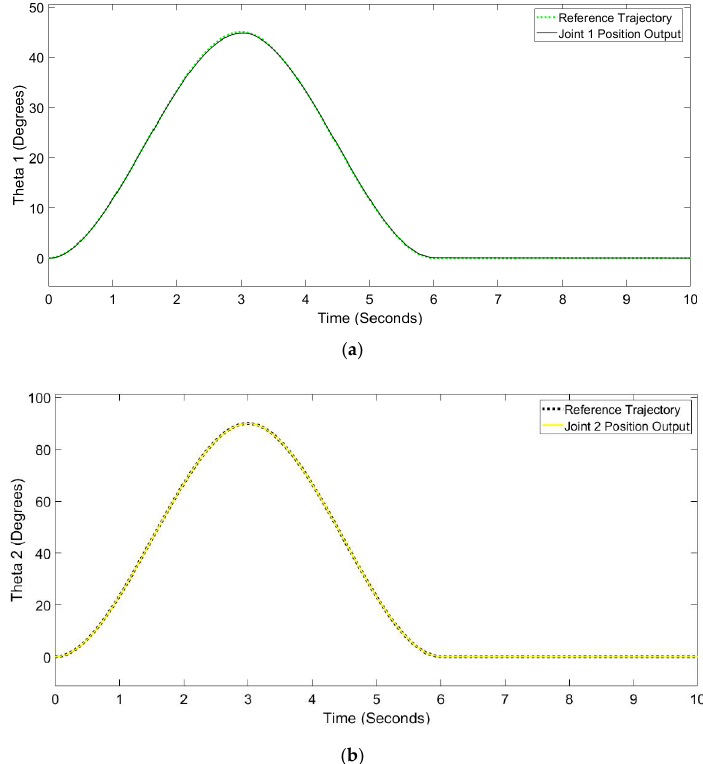
Figure 24. ( a ) Experimental position responses of shoulder joint A/A ( θ 1 ); ( b ) Experimental position responses of shoulder joint F/E ( θ 2 ).